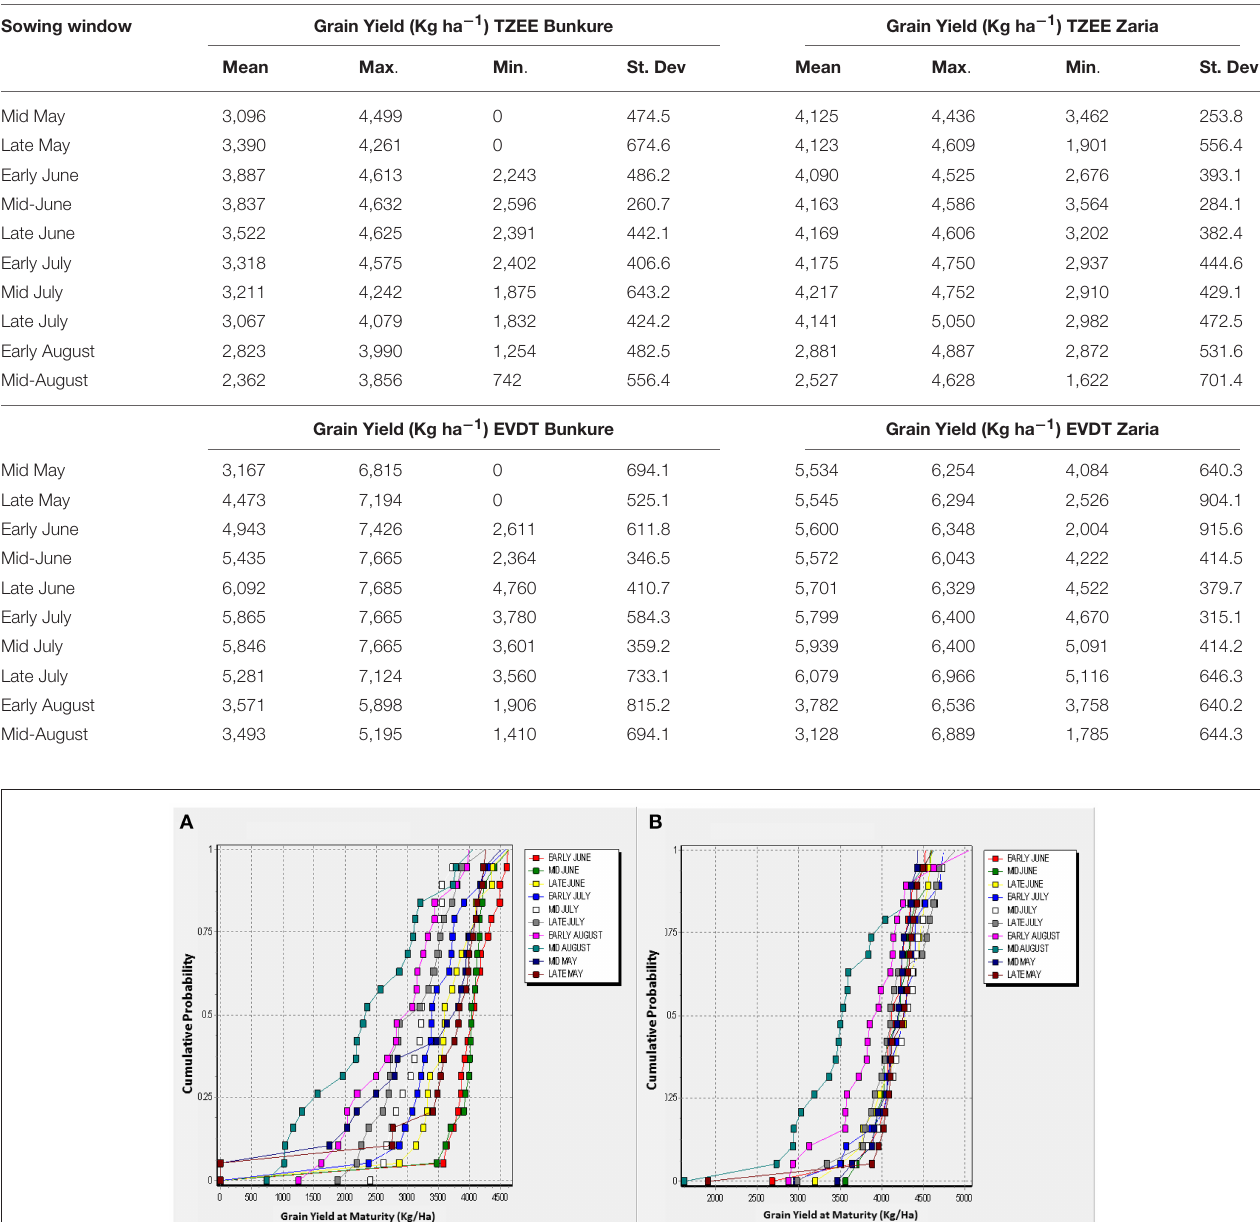
TABLE 7 | Result of 26 year seasonal analysis using different planting windows for early and extra-early maize in Bunkure and Zaria. Sowing window